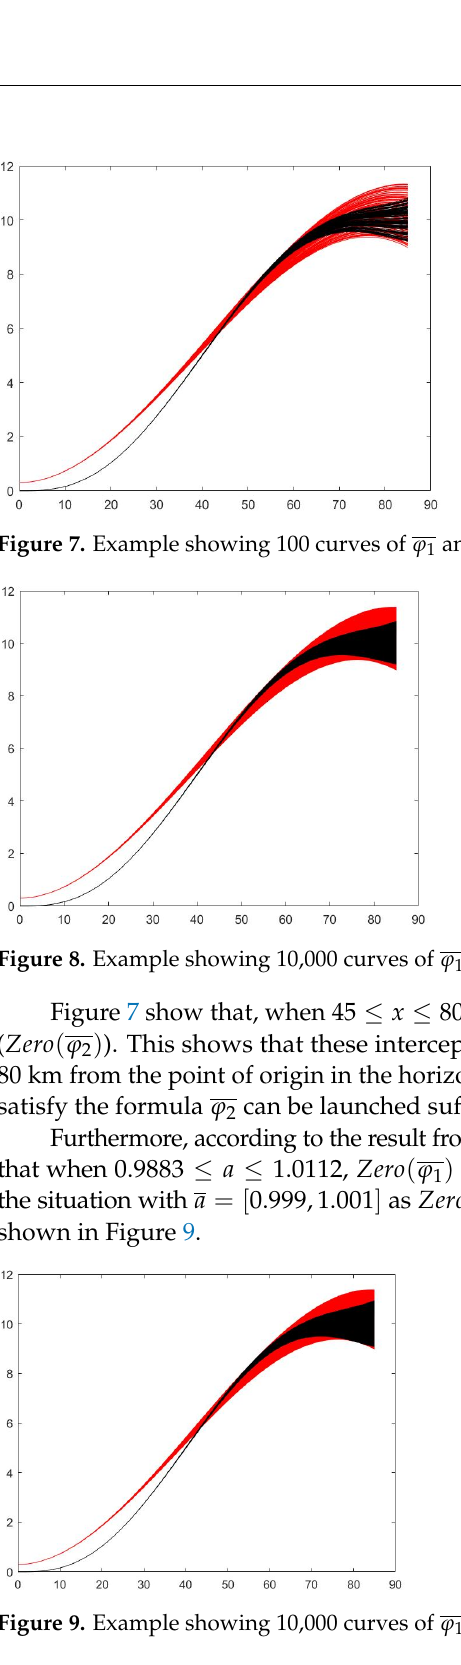
ϕ ϕ and 2 with 0.9883 1.0112 a ≤ ≤ .